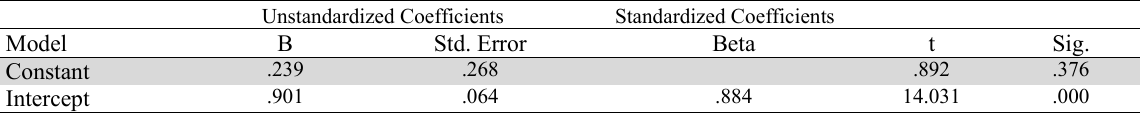
The results of the regression analysis Unstandardized